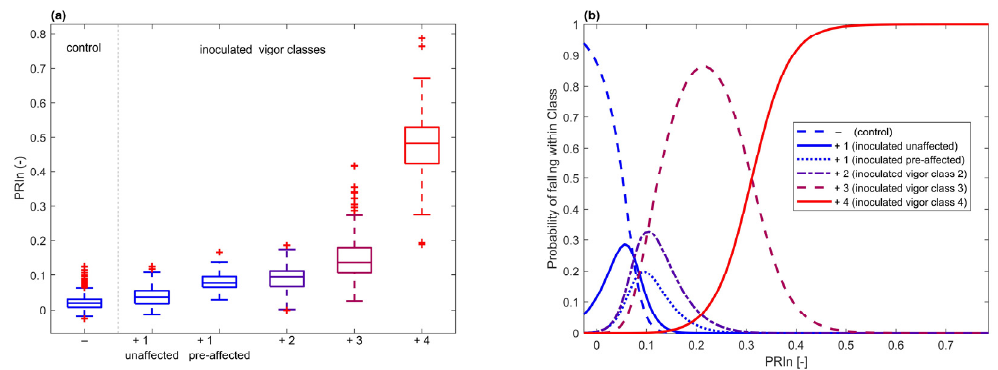
Figure 10. ( a ) PRIn distribution for all dates combined for ‘ − ’ non-inoculated control seedlings, ‘ + 1 una ff ected’ infected seedlings that remained una ff ected in terms of vigor for the duration of the experiment, ‘ + 1 pre-a ff ected’ infected seedlings that were not a ff ected in terms of vigor on the date that PRIn was calculated but were a ff ected during the next visual assessment, ‘ + 2’, ‘ + 3’, and ‘ + 4’ infected seedlings in vigor classes 2, 3, and 4, respectively. ( b ) Multinomial regression for probabilistic classification using PRIn, showing the ability of this single VI to separate seedlings for vigor classes.